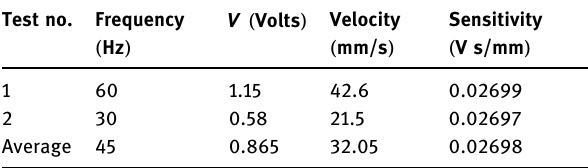
Table 3: Geophone characteristics at sample frequencies